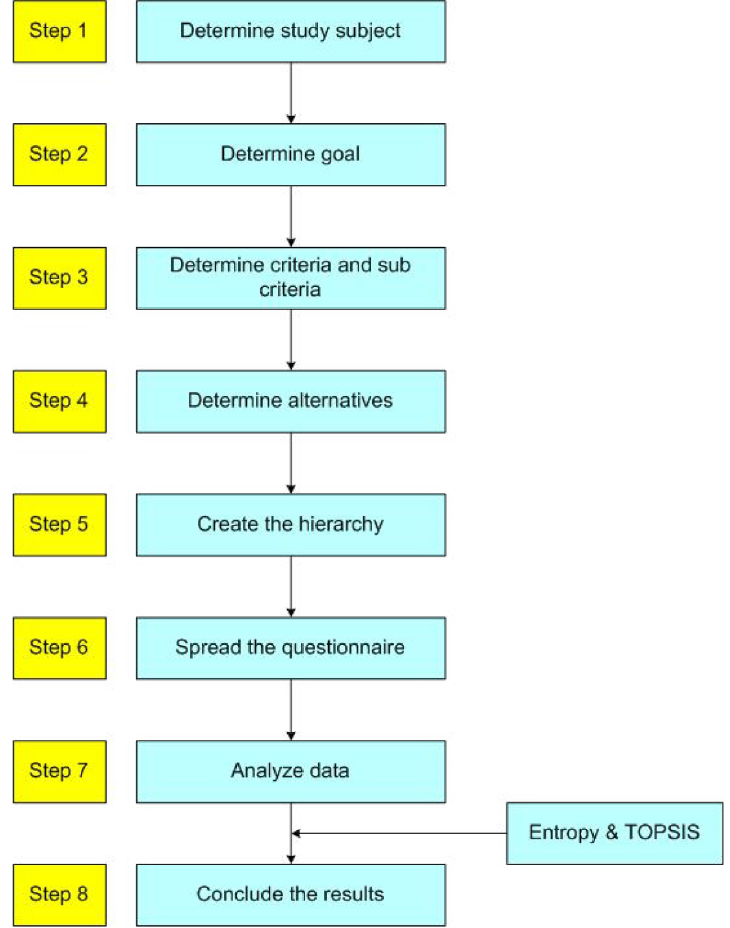
Figure 1. Evaluation